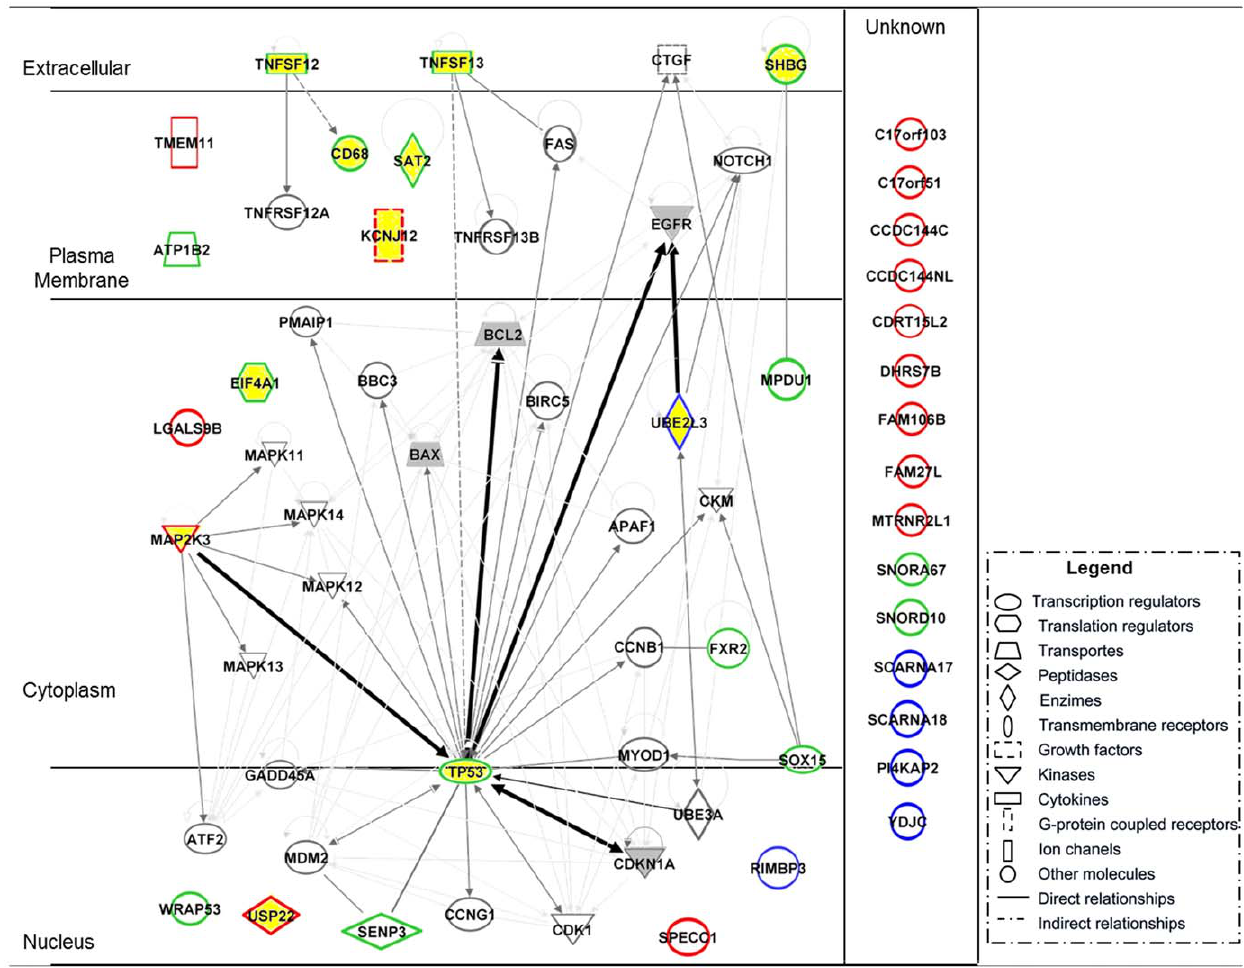
Figure 2. Schematic representation of the network of interactions observed between genes encoded at the 17p11.2 (genes highlighted in red), 17p13.1 (genes highlighted in green) and 22q11.2 (genes highlighted in blue) chromosomal regions, and molecules downstream molecules regulated by these genes which have been associated with cancer or cancer related signalling pathways. Genes highlighted in yellow are encoded at the three chromosomal regions referred above and they have been previously associated with cancer; genes highlighted in grey are considered as biomarkers for sCRC.